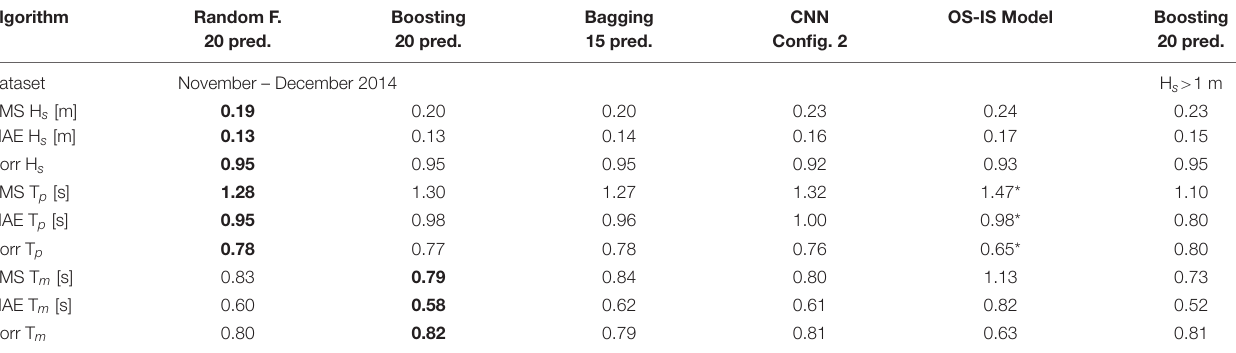
TABLE 2 | Performance of the ML models trained over the data from 2014 and validated over the data from November to December 2014 (6229 records). Algorithm Random F.